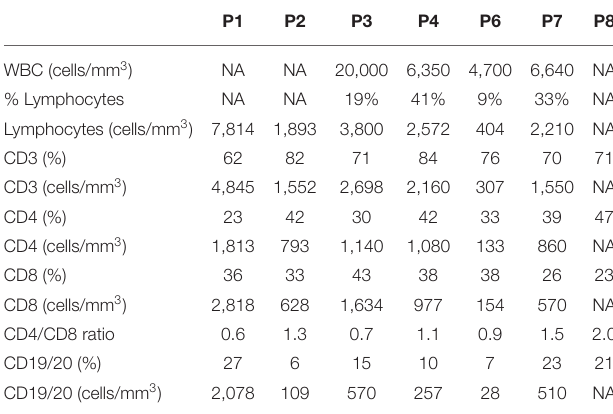
TABLE 2 | Lymphocyte Immunophenotyping among patients with IL10/IL10R mutations.